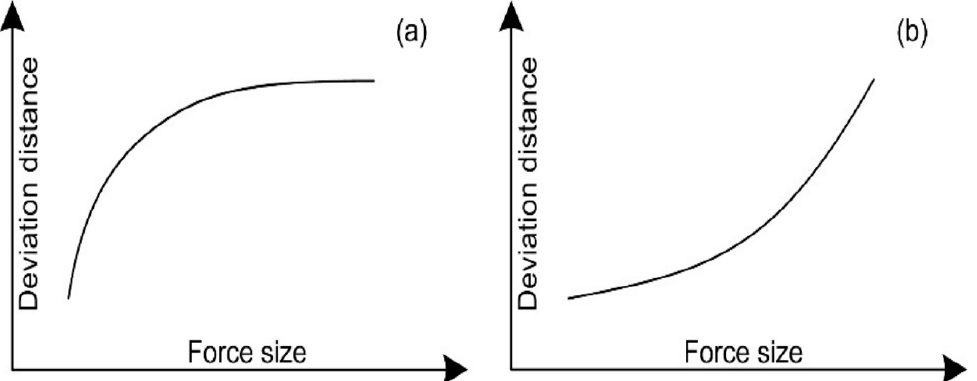
Figure 5. Graph of force versus object offset distance: ( a ) creep characteristics and ( b ) relaxation characteristics.